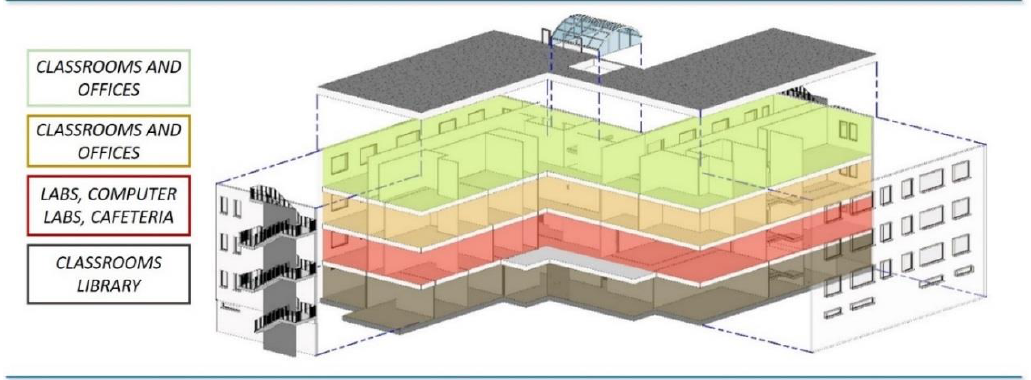
Figure 1. Axonometric exploded view with the uses for each floor.